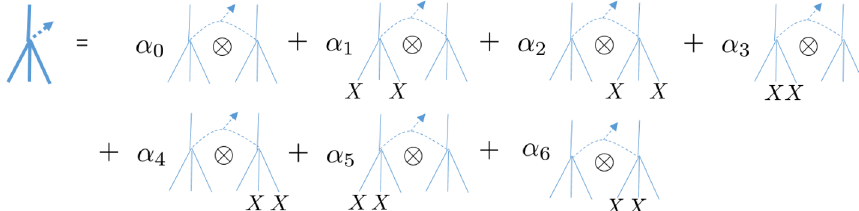
Figure 42. Consider approximate isometries constructed as such. Because no weight two X type operator can be the logical operator in this concatenated code, they are detectable X type errors, and are orthogonal states. Like before, the physical qubits of the second copy are collectively rotated by 90 degrees relative to the